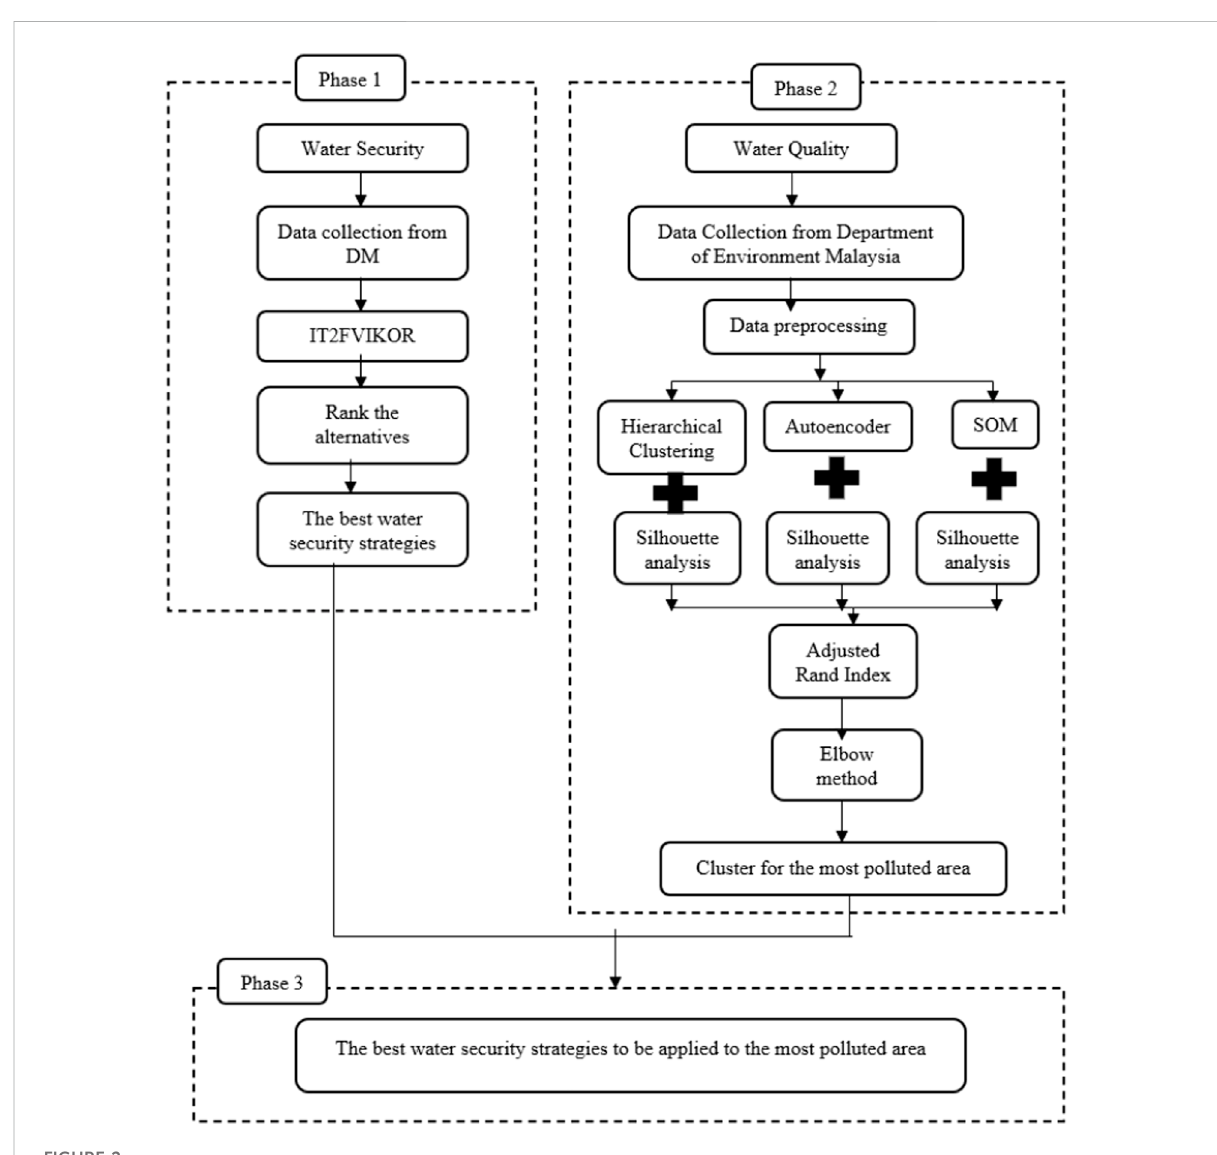
FIGURE 2 A process of integrated IT2FVIKOR with machine learning to the real